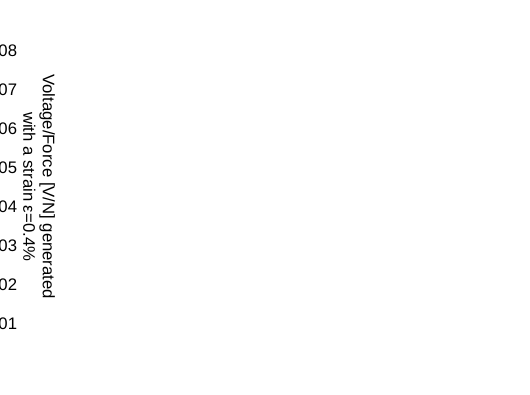
Figure 11. Average volts per newton generated by the 3D printed PVDF and ZnO-PVDF nanocom- posite samples as function of the percentage of ZnO for low (red) and high (blue) cooling rates. Experimental testing also revealed a frequency dependency of the signal generated by the test samples. As the setting frequency on the locking amplifier increased above the driven frequency, the signal of the PVDF-nano composite samples became sinusoidal and its frequency increased proportional to the locking amplifier’s frequency set point. When the locking amplifier matching frequency is set to two times the driven frequency, then the specimen signal match (Figure 12a,b) the input force frequency. Setting the locking amplifier at a higher matching frequency increases the signal frequency and decreases the signal amplitude (Figure 12c,d), while the frequency response remains constant, ZnO increases (Figure 11) the signal amplitude, with 10% of ZnO content producing the maximum volts per newton of applied force, ≈ 0.0175 V/N. Similarly, HCR samples (Figures 11 and 12) increase the voltage to force signal by approximately two times regardless of the ZnO content, with the exception of the 5% of ZnO. 5ZnO also presents the lowest (Figure 5) alpha to beta transmittance difference, and its melting point (Figure 4) is similar to pristine PVDF, suggesting a lower percentage of β -phase formation. This effect is attributed to the higher concentration and agglomeration of ZnO (Figure S3).